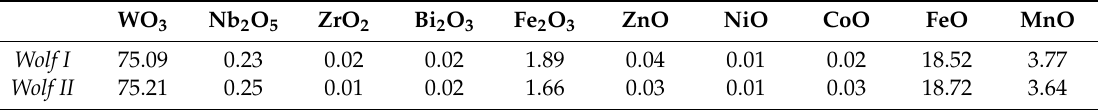
Table 7. Elemental median concentration values (wt %) characterizing each wolframite